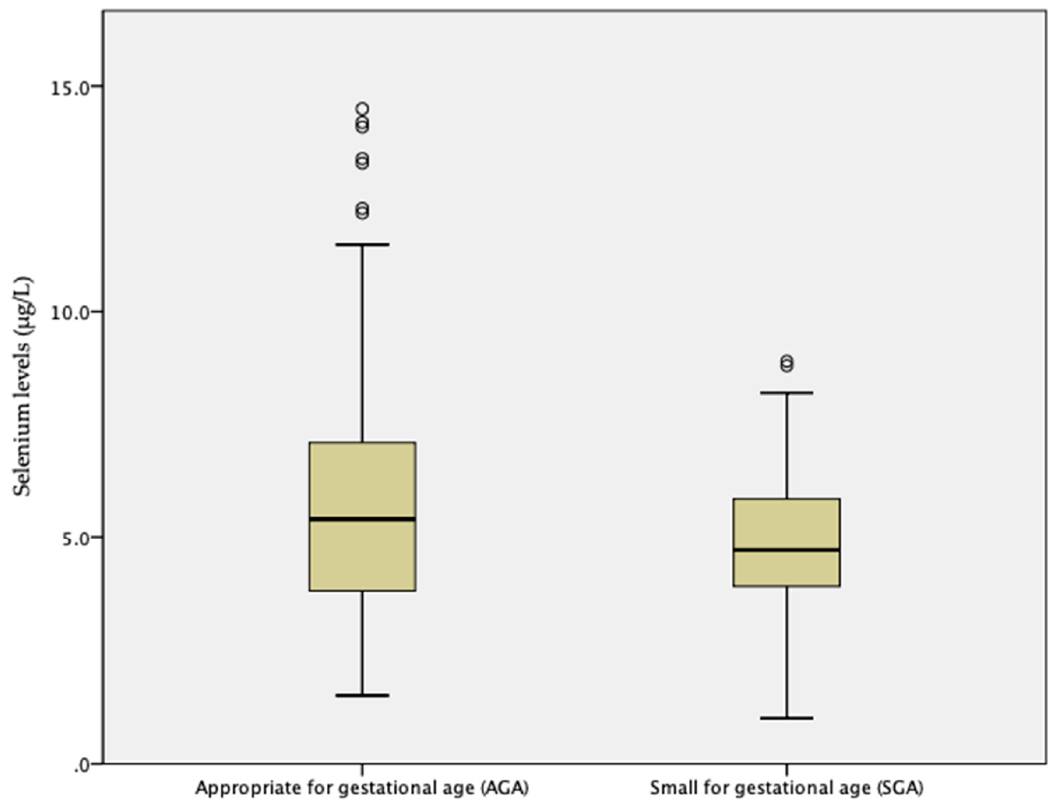
Figure 2. Comparison of mean Se concentrations in amniotic fluid. Se levels were significantly different between AGA and SGA newborns ( t = − 2.44; p = 0.017).